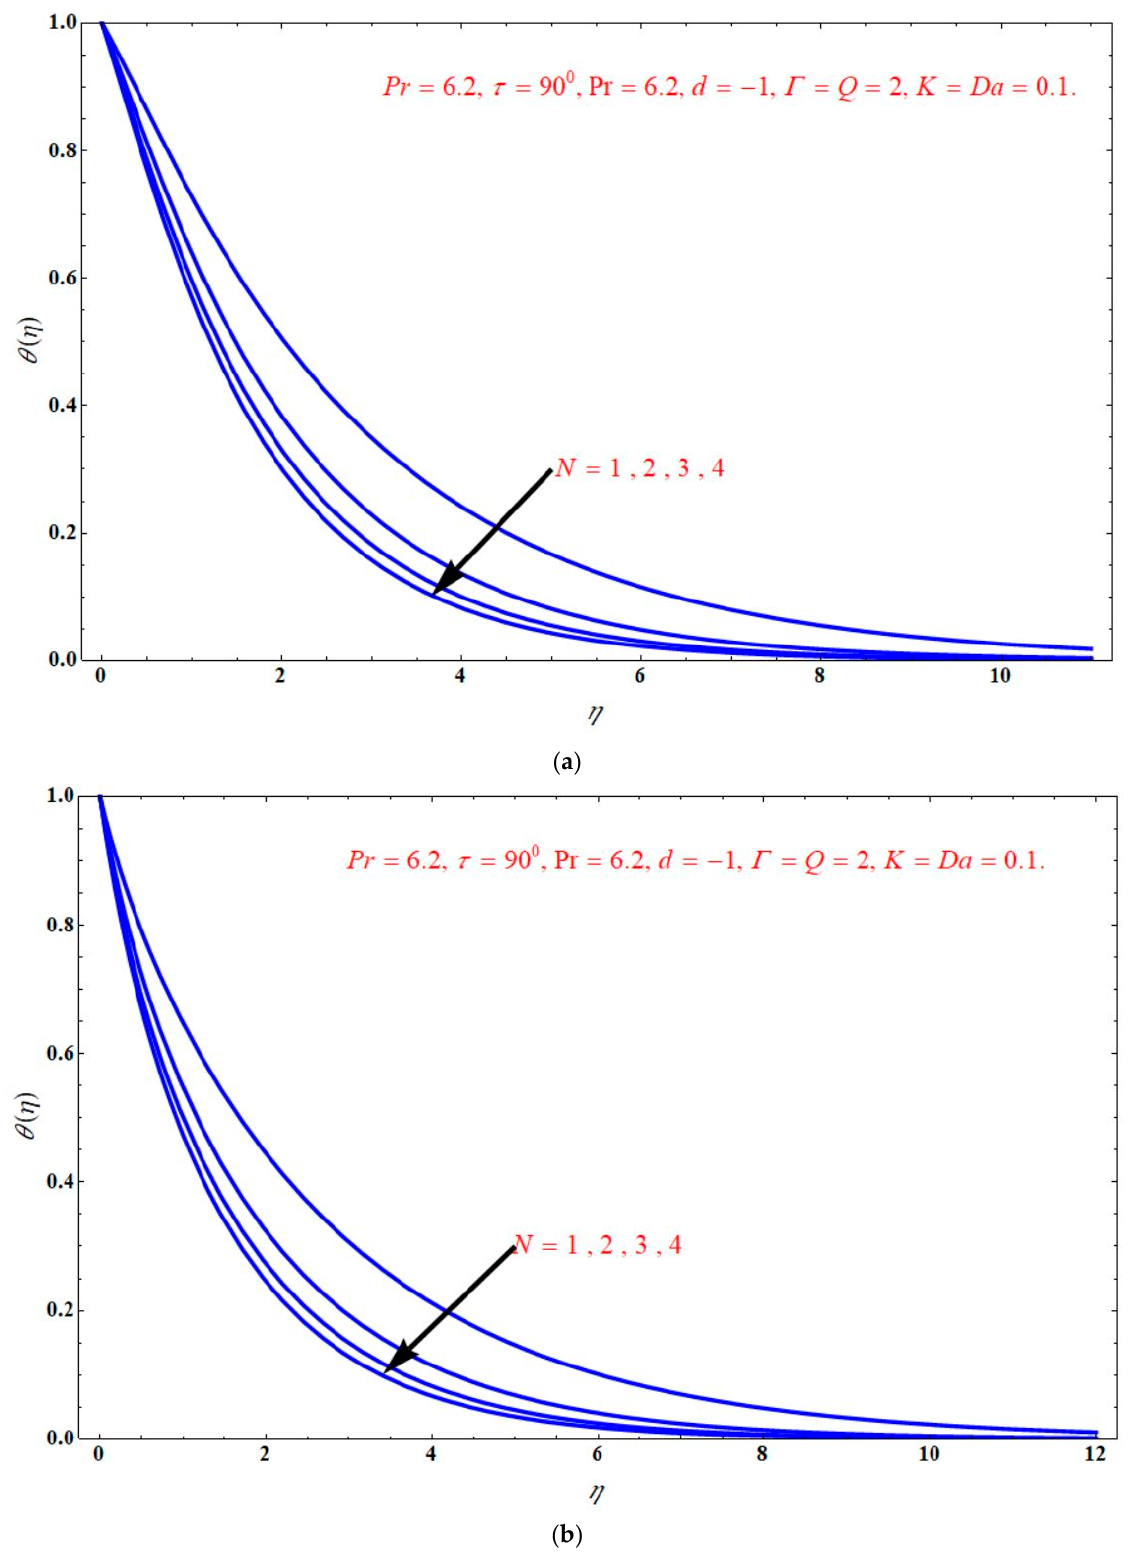
( ) θ η η Figure 7. Impact of θ ( η ) on η for various choices of Q for both ( a ) d = 1 and ( b ) d = − Figure 7. Impact of on for various choices of Q for both ( a ) 1 d 1 d = −